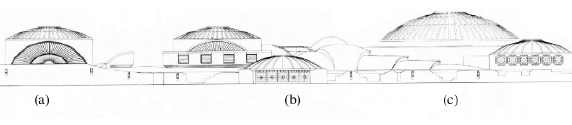
Figure 5. Plan drawing of National Ballet School. The annotations reflect where spherical panoramas for the virtual tour were taken.